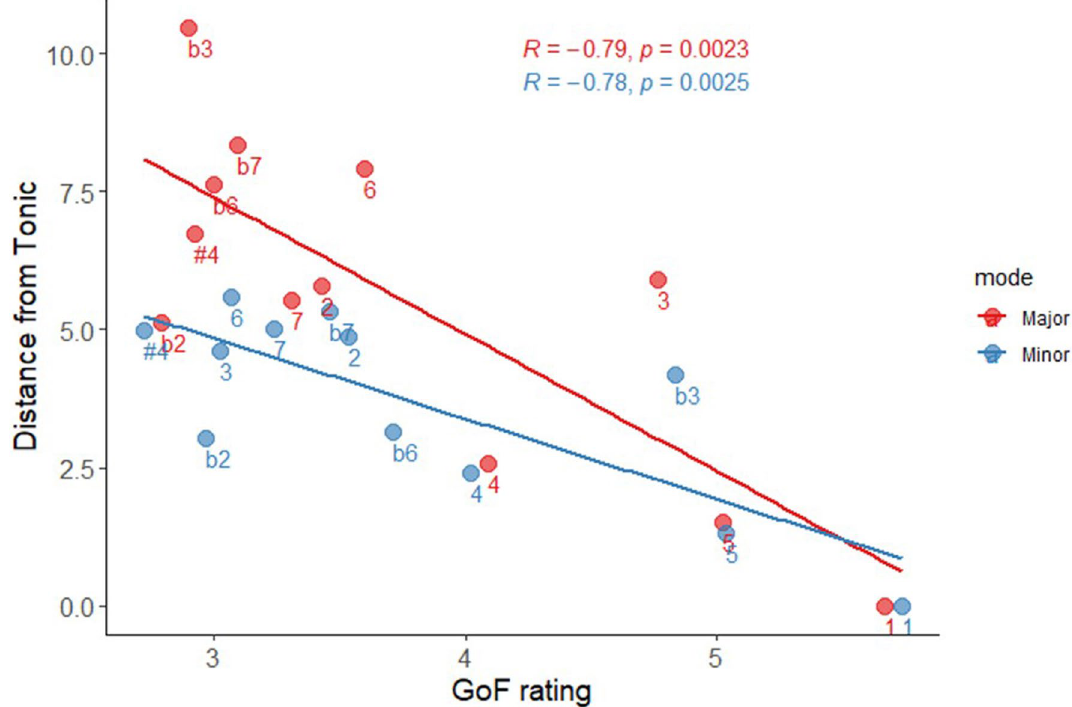
Figure 4. Mean distance from the tonic of each scale degree in Major (red) and Minor (blue), as a function of GoF rating (independently obtained in ref. 33 ), in Experiment 1. Scale degrees are normalized into C Major and C minor (i.e., 1 = the tonic scale degree), # symbols represent raised degrees (e.g., #4 = the triton), and b symbols represent lowered degrees (e.g., b2 = = lowered